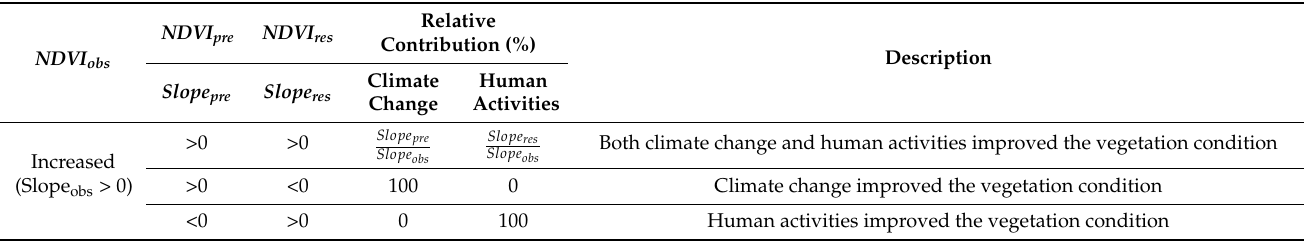
Table 1. Methods for assessing the relative proportions and roles of climate change and human activities on vegetation